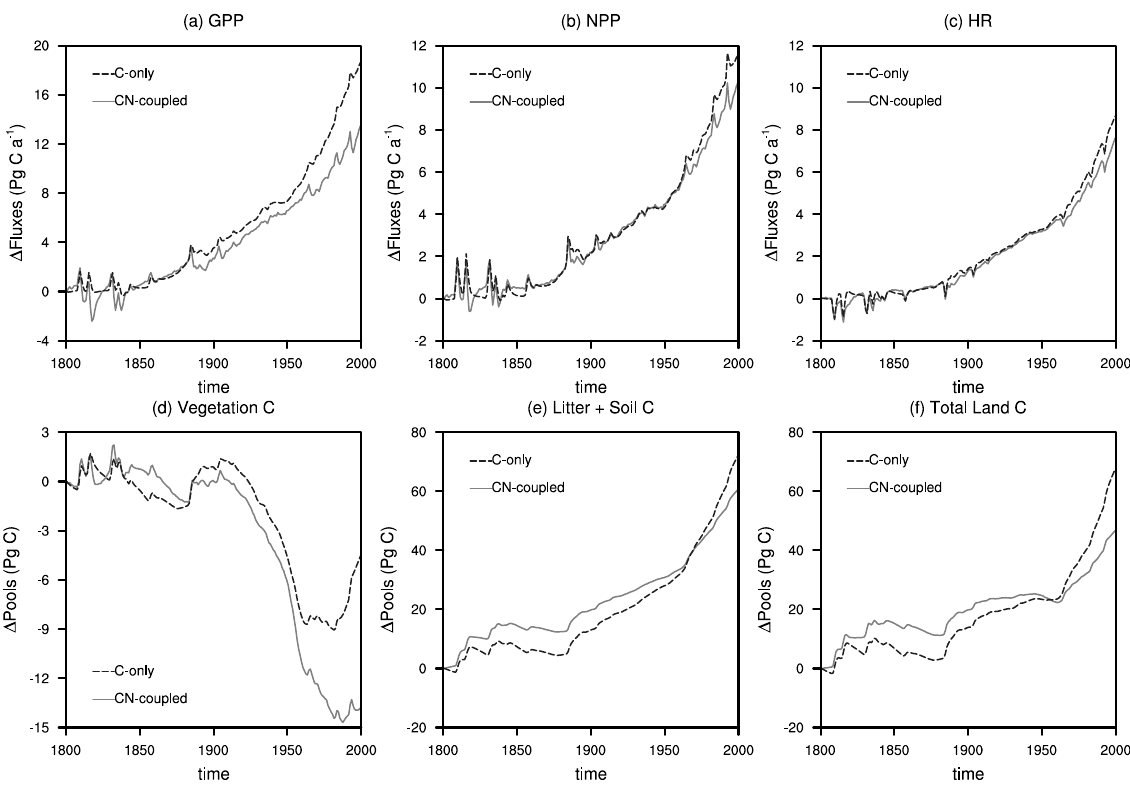
Fig. 8. Changes of carbon fluxes from 1800 to 2000: (a) GPP = gross primary production, (b) NPP = net primary production and (c) HR = heterotrophic respiration and changes of carbon pools (d) vegetation, (e) litter plus soil and (d) total, i.e., the sum of (d) and (e) for UVic-CN (grey solid line) and UVic C-only (black dashed line)